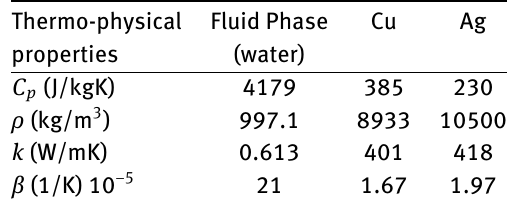
Table 1: Thermo-physical properties of the base fluid and the nanoparticles at T = 25 ◦